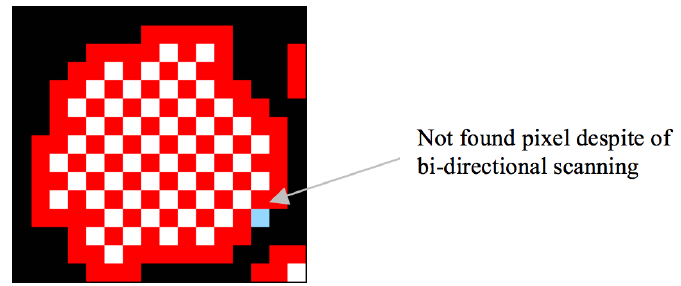
Figure 22. Result of the proposed algorithm by using bidirectional